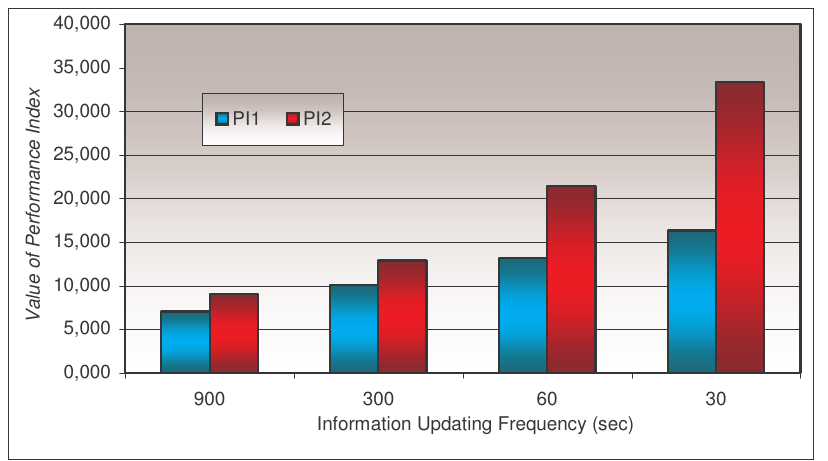
Figure 7. The behavior of performance indices PI1 and PI2 under the influence of traffic information provided over different updating